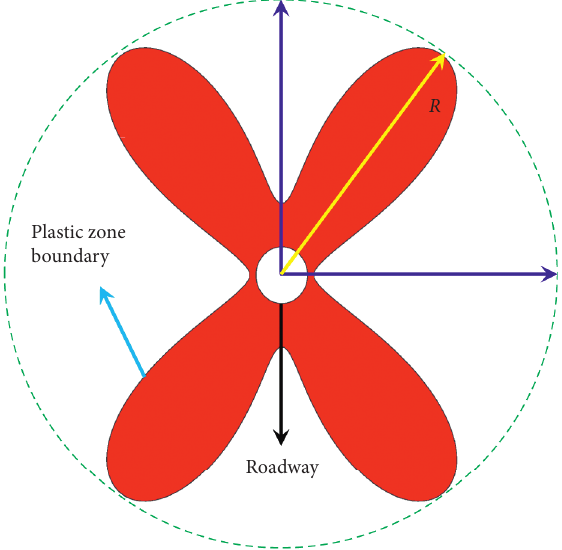
Figure 4: Effective radius of plastic zone.